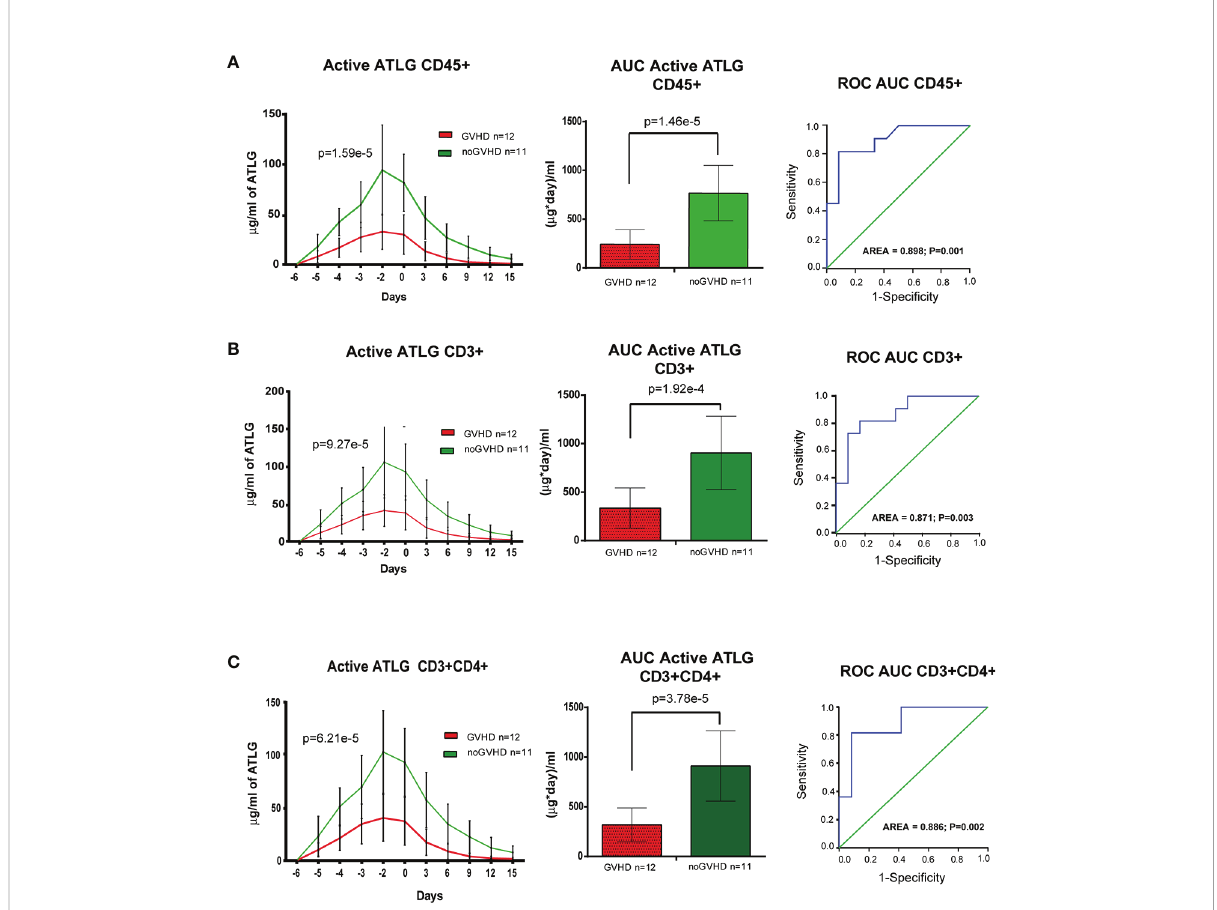
FIGURE 2 Pharmacokinetic analysis of active ATLG. (A) , Pharmacokinetic analysis (left panel), AUC (middle panel) and ROC analysis (right panel) of active ATLG bound to CD45+cells from day -6 to day +15. (B) , Pharmacokinetic analysis (left panel), AUC (middle panel) and ROC analysis (right panel) of active ATLG bound to CD3+ lymphocytes from day -6 to day +15. (C) , Pharmacokinetic analysis (left panel), AUC (middle panel) and ROC analysis (right panel) of active ATLG bound CD3+/CD4+ lymphocytes from day -6 to day +15. The data are expressed as mean +/- S.D. p values refer to GLM for repeated measures, Left panels, and t -test for right